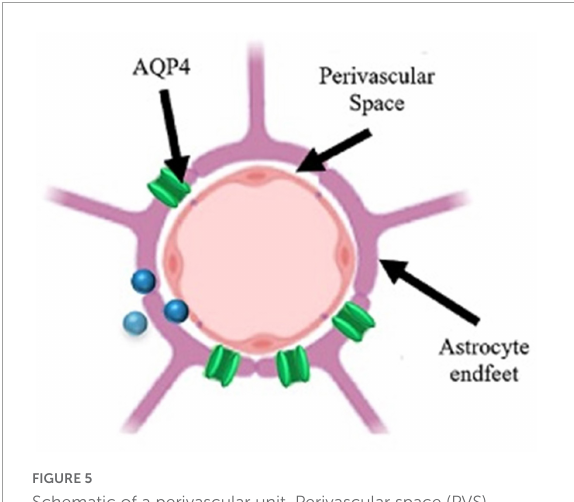
FIGURE5 Schematic of a perivascular unit. Perivascular space (PVS) separates the astrocyte end-feet from the blood vessel. AQP4 (aquaporin-4 channel) allows for the influx/efflux of solutes into the PVS for removal or distribution. The inability of the cerebrospinal fluid (CSF) to flow through the PVS results in stagnation and enlargement of the PVS. Figure adapted from Troili et al.